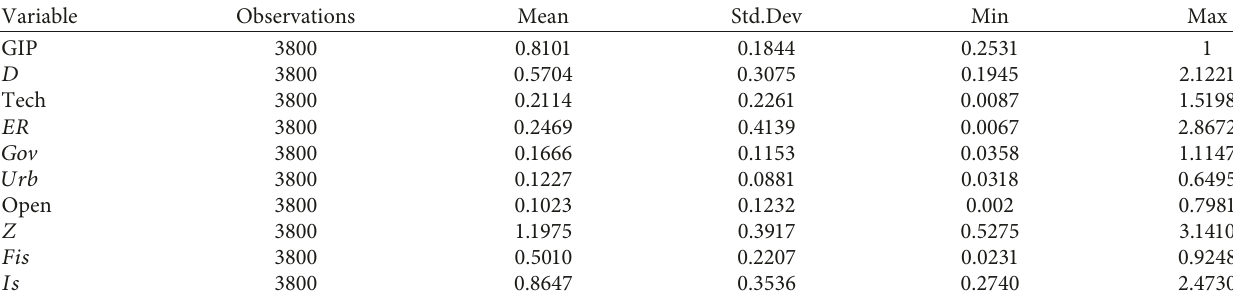
Table 2: Descriptive